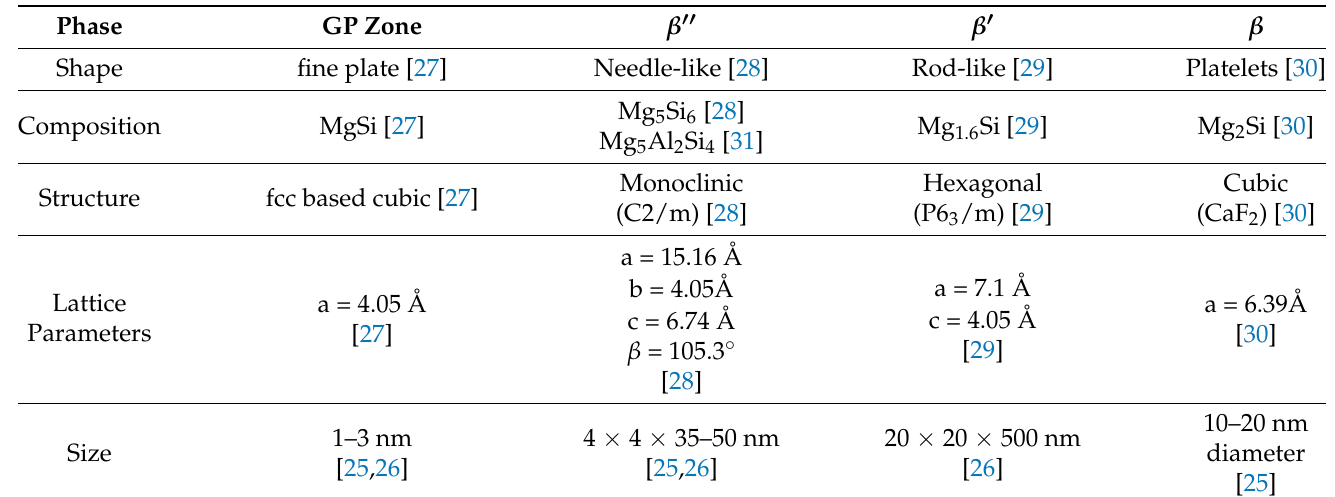
Table 4. Precipitation phases in the A356 alloy [25–30].